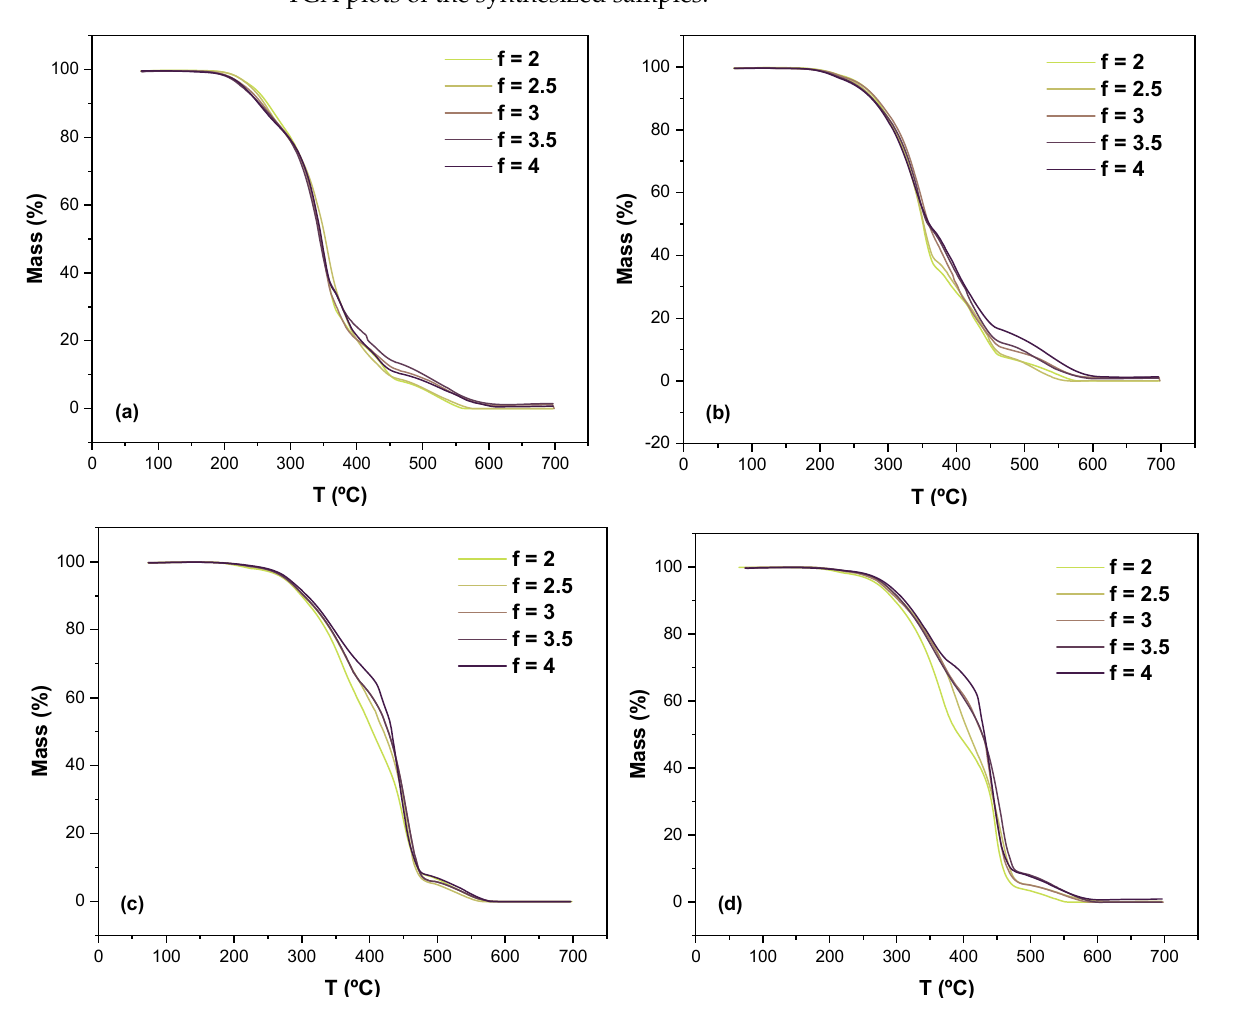
Figure 7. TGA analysis results. ( a ) EDA, ( b ) HMDA, ( c ) Pr–1075, ( d ) Pr–1075–DBA. Three different stages of mass loss are observed: the first one (270–350 °C) associated with the breakage of urethane, the second one (350–450 °C) with the degradation of ester and amide bonds and, finally, the last one (450–570 °C) assigned to aliphatic chain decom ‐ position.